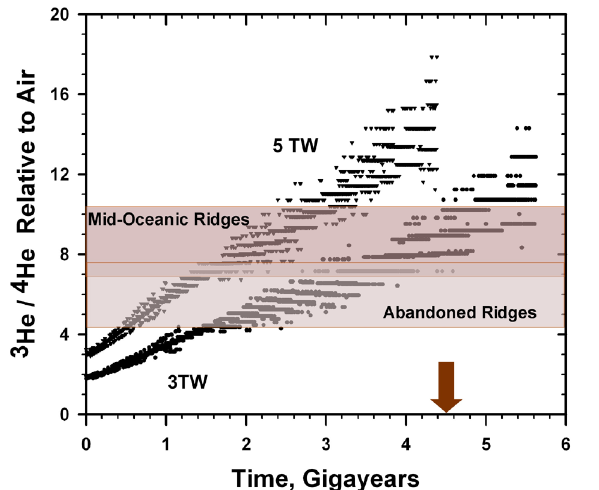
clear georeactor numerical simulations at 5TW (upper) and 3TW (lower) power levels, from (Herndon, 2003). The bands comprising the 95% confidence level for measured values from mid-oceanic ridge basalts (MORB) are indicated by the solid lines and shading. The age of the Earth is marked by the arrow. Note the distribu- tion of values at 4.5 gigayears, the approximate age of the Earth. The increasing values are the consequence of uranium fuel burn- up. Icelandic “plume” basalts present values ranging as high as 37 (Hilton et al., 1999). Adapted from Herndon